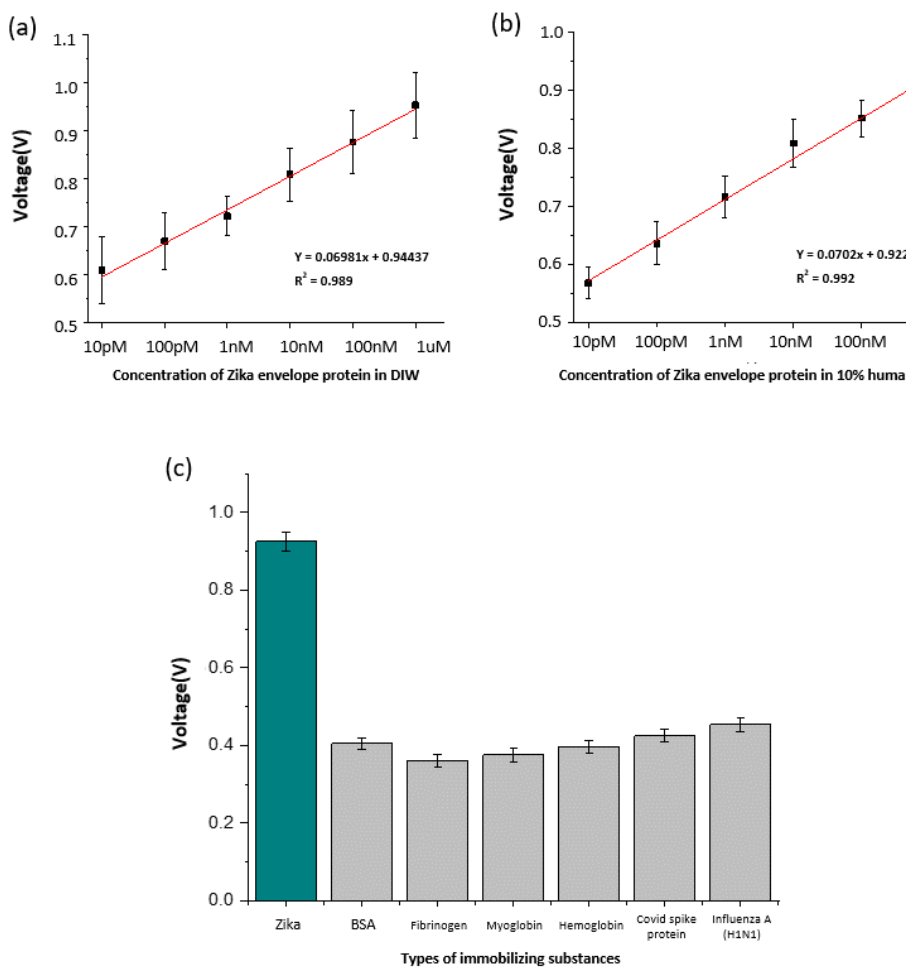
Figure 5. ( a ) Calibration curve according to the Zika envelope protein concentration. ( b ) Calibration curve according to the Zika envelope protein concentration in 10% human serum. ( c ) Comparison of the selectivity of Zika envelope protein with bio-derived materials and other virus proteins in the designed electrodes.